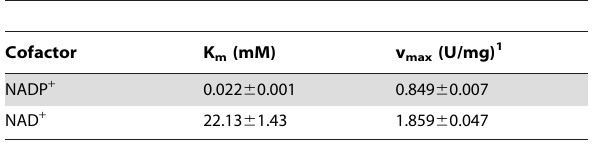
Table 5. Kinetic parameters of refolded Ta AlDH with different cofactors NAD + and NADP + at 50 u C, pH 6.2.